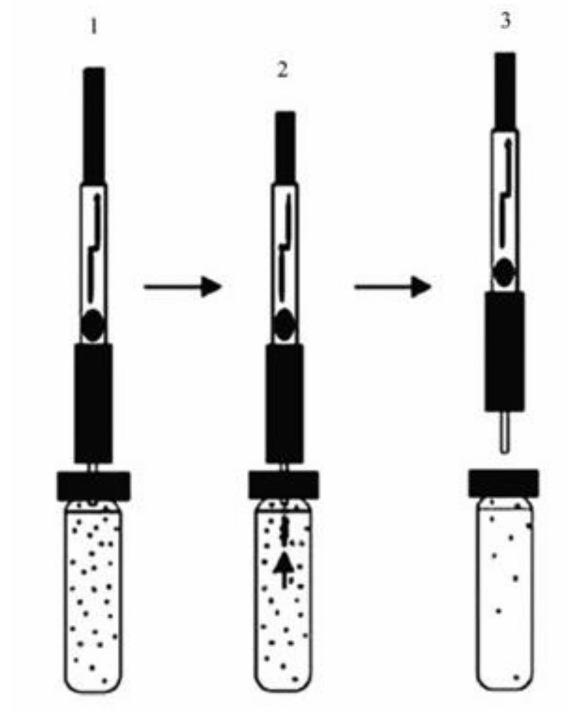
Figure 5. SPME procedure: (1) fiber in the sample; (2) extraction of the target analytes; (3) target